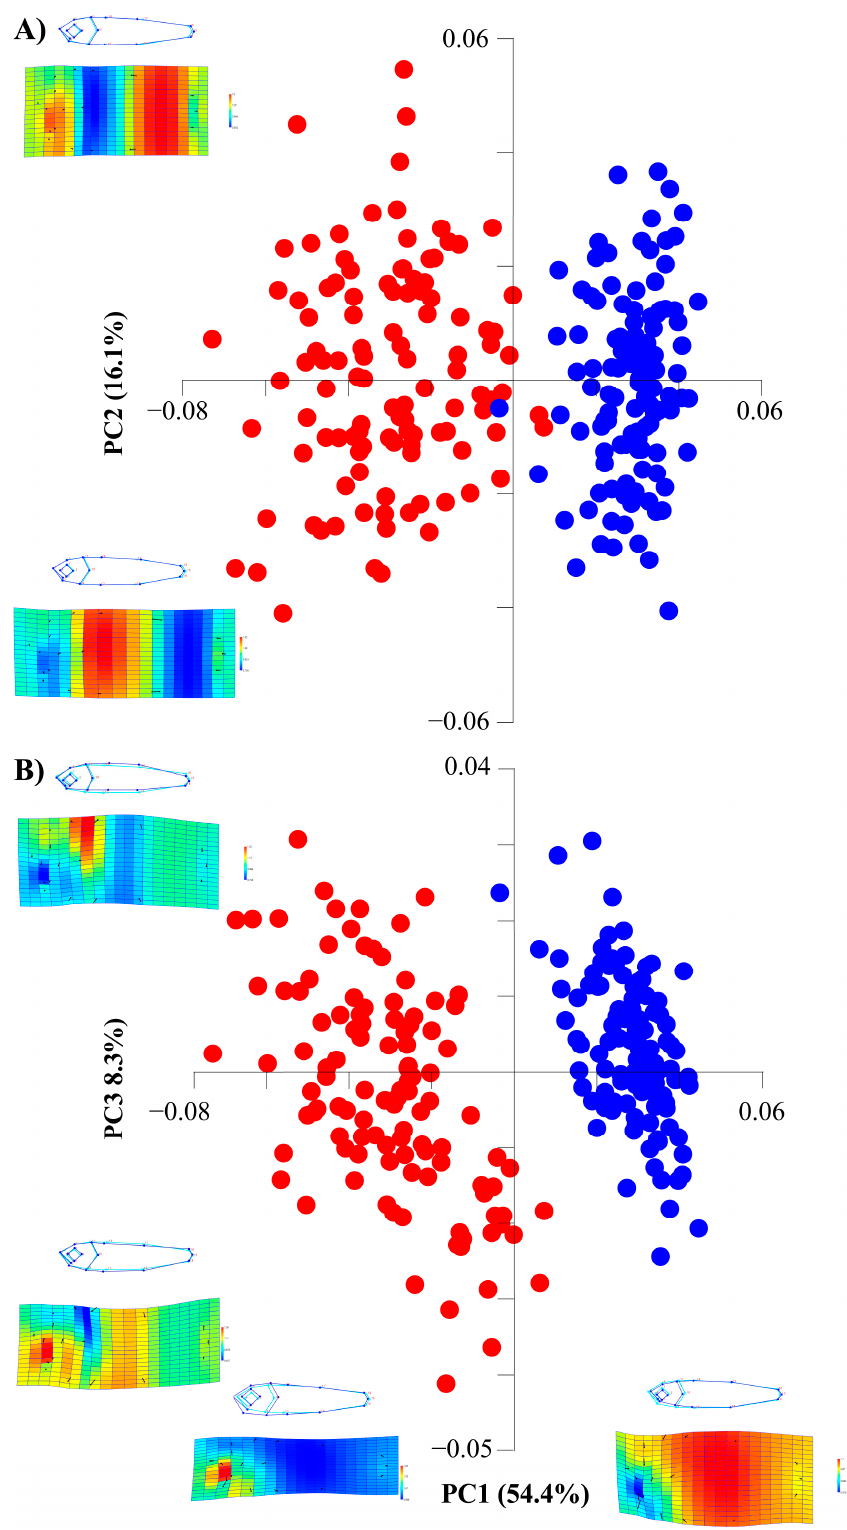
Figure 2. Morphospace illustrations between PC1-PC2 ( A ) and PC1- PC3 ( B ) for detecting body shape variations during larval and juvenile stages of Chelon auratus . Red dots are larvae (24 dph), blue dots are juveniles (54 dph). Thin-plate spline deformation grid displays body shape ranges; expanded shape is represented with warm colors and contracted shape in cold colors.